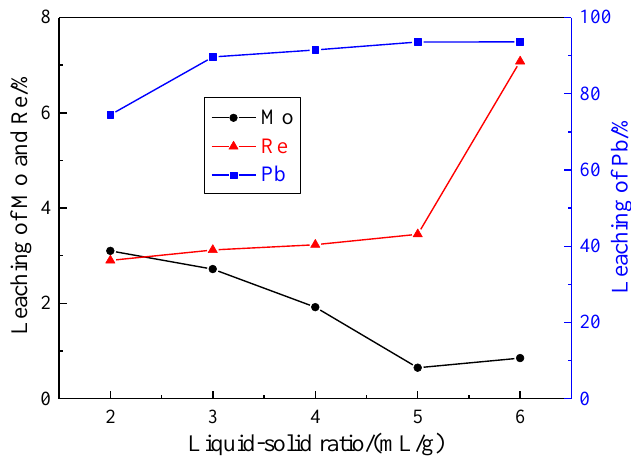
Figure 6. Effect of liquid-solid ratio on the leaching of Mo, Re and Pb.